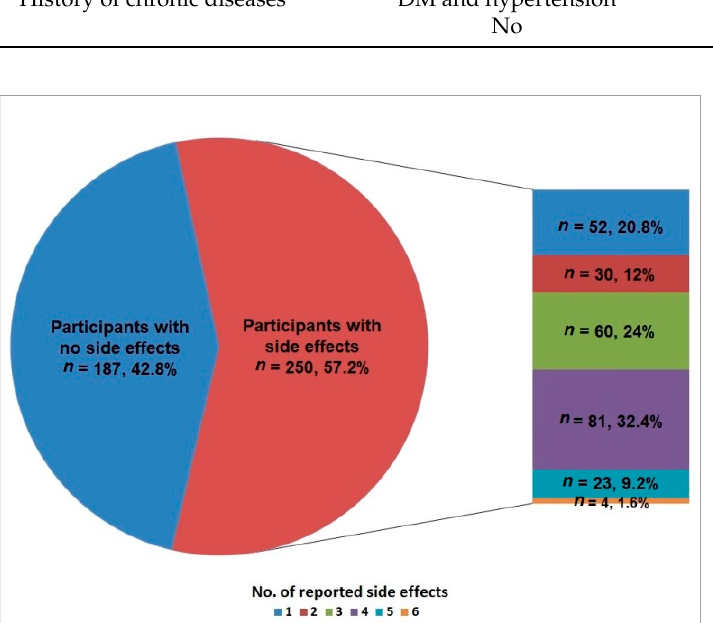
Figure 1. Total number of COVID-19 vaccine side-effects reported among the participants. Among the 250 HCWs who developed COVID-19 post-vaccination side-effects, Figure 2 shows that pain and redness at the site of injection (80.0%) and fever (73.2%) were the most frequently reported side-effects, followed by whole-body pain/fatigue (56.4%) and headache (48.8%). On the other hand, the least frequently reported side-effects were diarrhea at 1.2%, shortness of breath, chest tightness, and vomiting at 0.8% each, and backache and skin rash at 0.4%